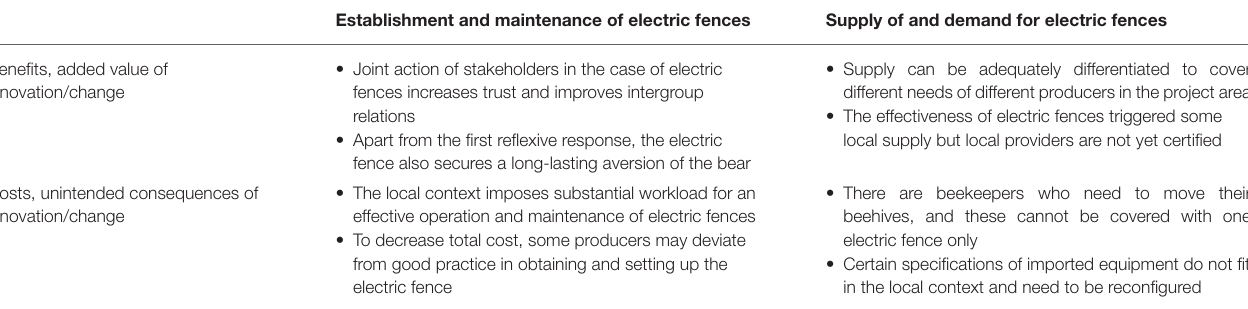
TABLE 5 | Mixed-motive template for electric fences.